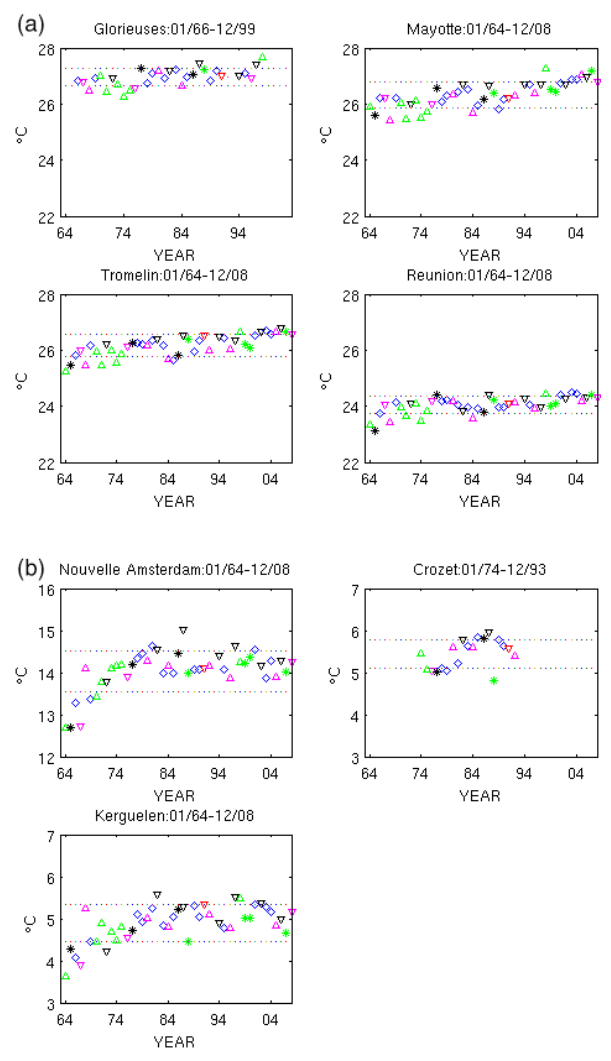
Figure 2. Time series of in situ measurements of mean yearly tem- perature at each island and the standard deviation (dotted). The red triangle is the 1991 (Pinatubo eruption) value. The others symbols are as follows: positive IOD – triangle down; negative IOD – trian- gle up; neither negative nor positive IOD – star. Green – La Niña; black – El Niño; magenta – neither La Niña nor El Niño. Years without any sign: